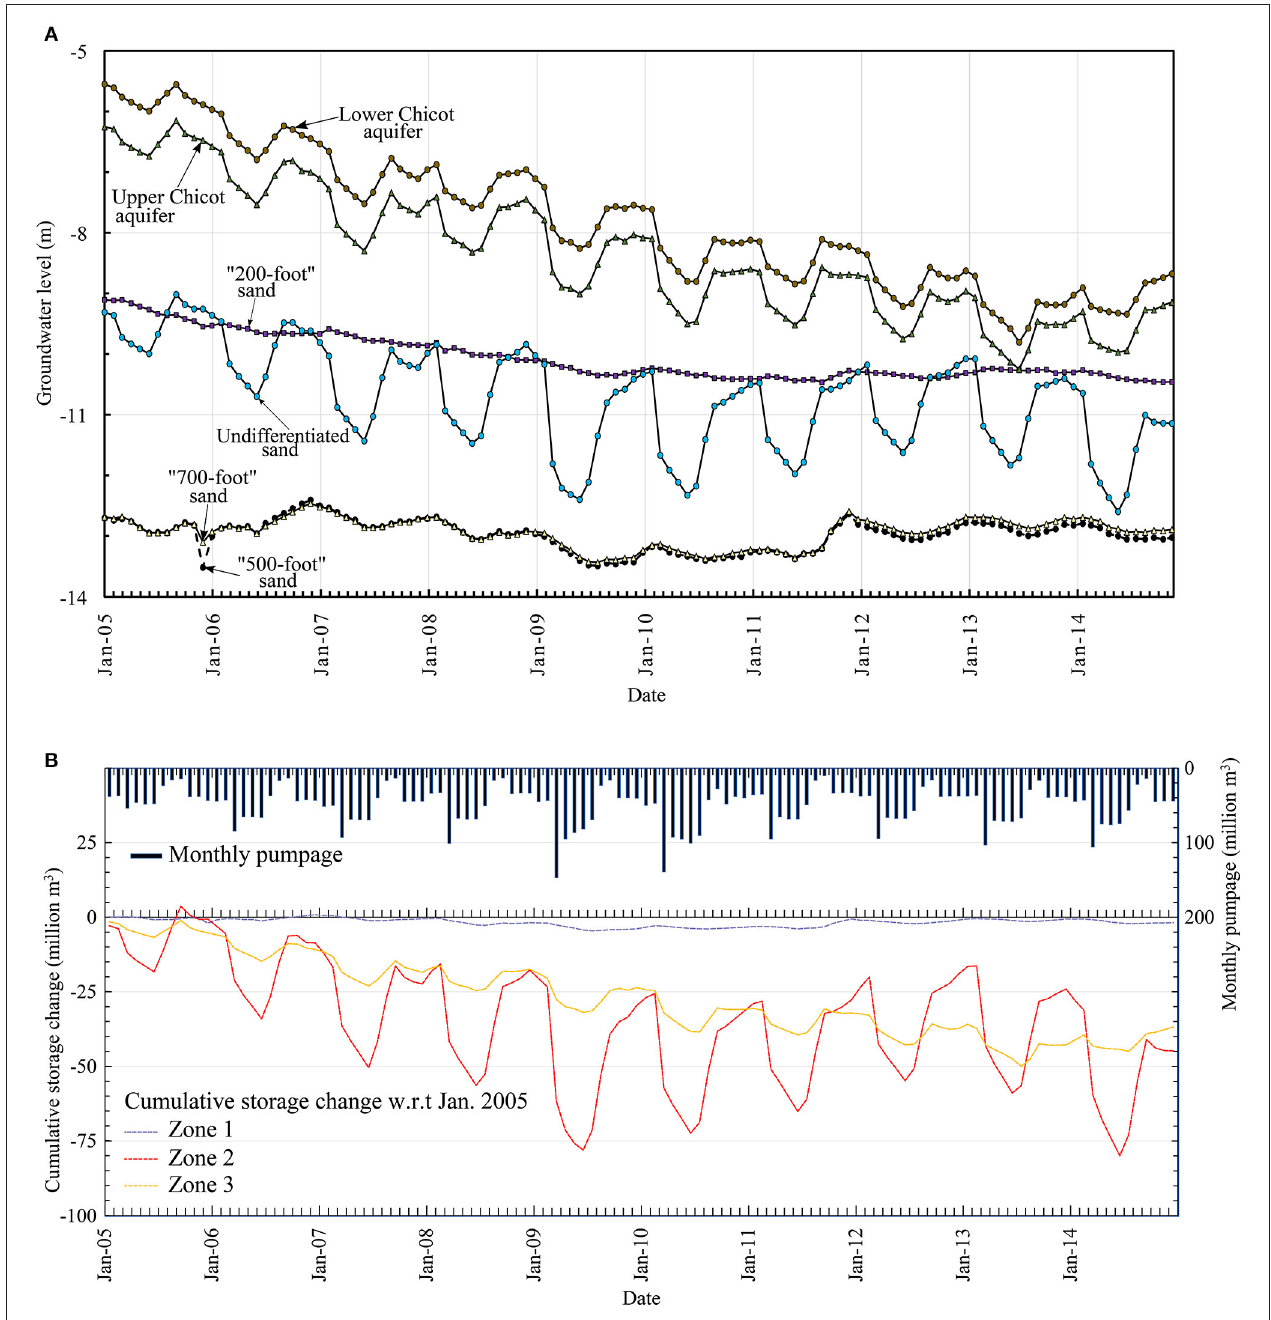
FIGURE 12 | (A) Mean monthly groundwater level (m) in different sands of the Chicot aquifer system from January 2005 to December 2014. The groundwater level datum is NAVD 88, and (B) estimated cumulative groundwater storage change (million m 3 ) with respect to January 2005 for Zone 1, 2, and 3, and monthly pumpage (million m 3